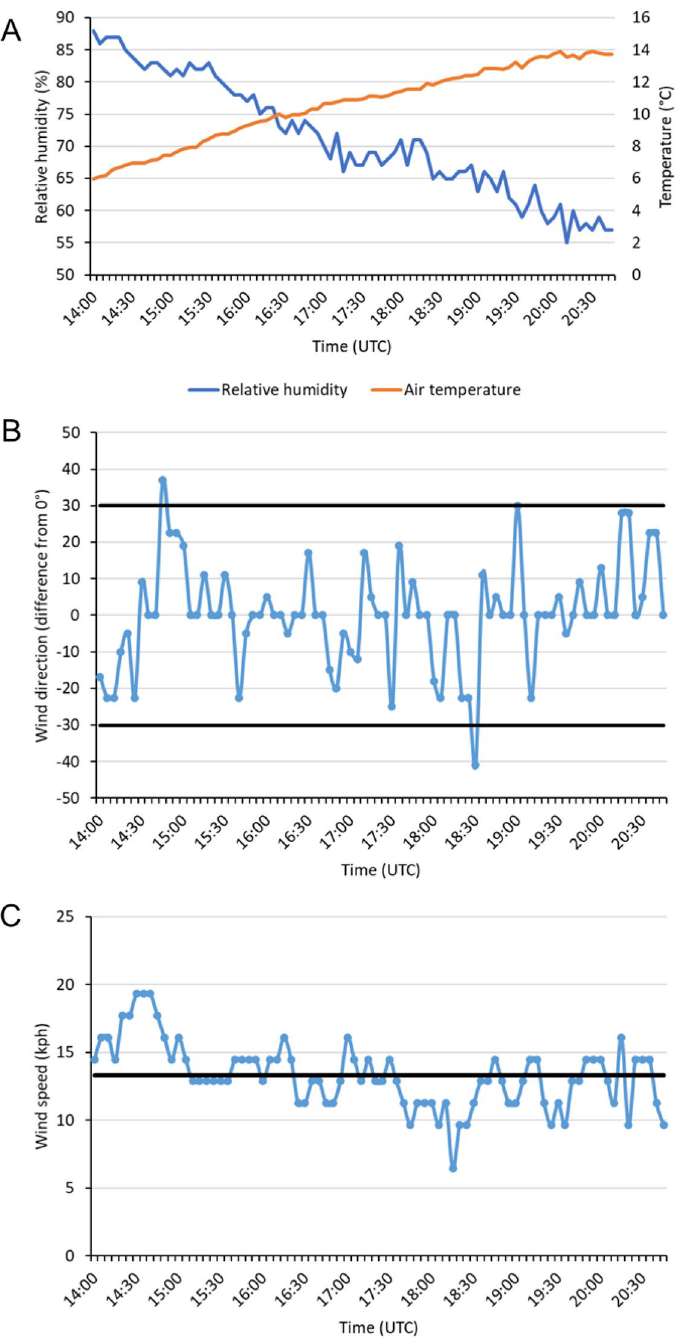
Figure 1. Meteorological data collected throughout the duration of the spray drift field experiment including air temperature and relative humidity ( A ), wind direction deflection from 0°( B ), and wind speed ( C ). The horizontal black lines in ( B ) represent the 30° maximum wind direction deviation permitted under guidelines established by the US EPA 36 . The horizontal black line in ( C ) represents the average wind speed over the duration of the experiment (13